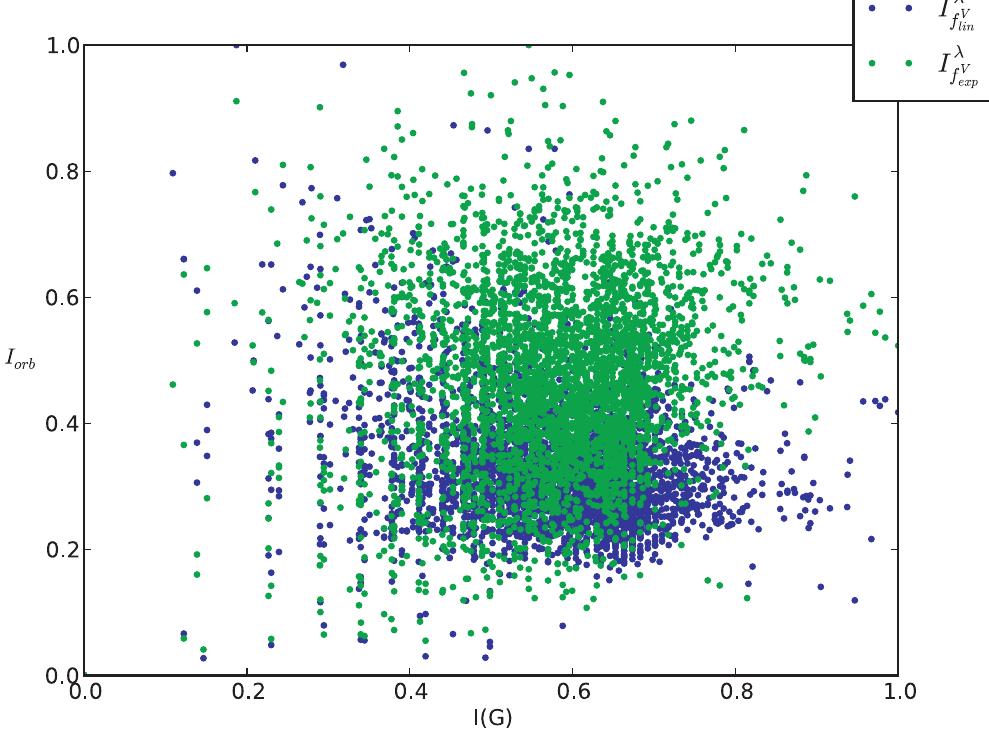
, I l for AG 3982. (reference label: scatter_plot2). f V exp f V lin